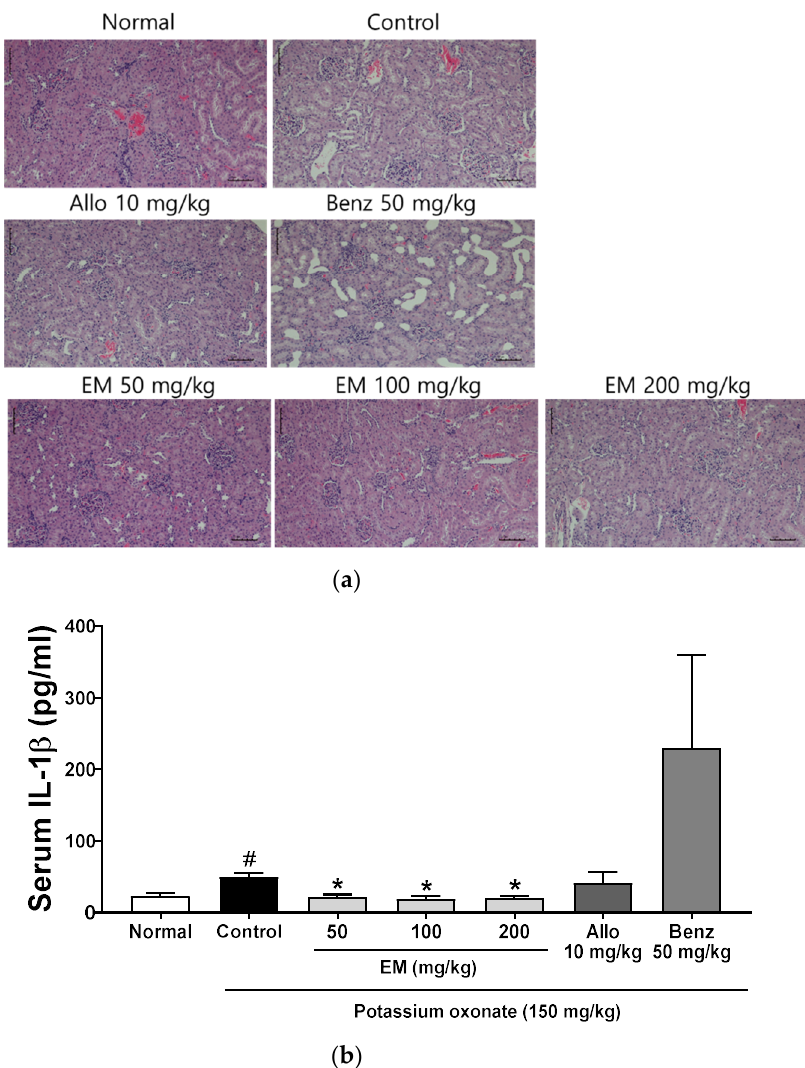
Figure 3. The effects of EM on renal inflammation in rats with PO-induced hyperuricemia: ( a ) Renal histopathological changes (original magnification, 200×). ( b ) Serum IL-1β levels by ELISA. ( n = 5 per group). Allo, allopurinol; Benz, benzbromarone. # p < 0.05 vs. the normal group; * p < 0.05 vs. the PO group.